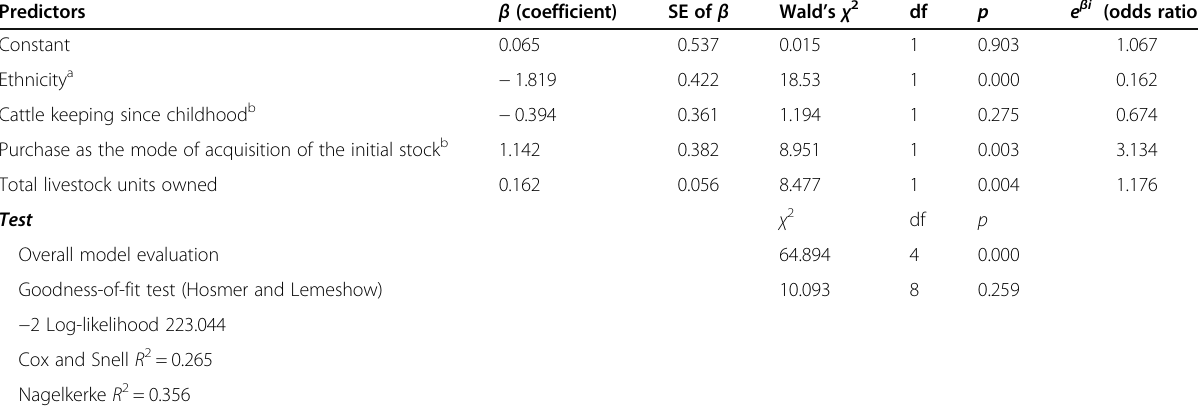
Table 5 Logistic regression predicting the practice of entrustment by cattle owners ( n = 211)